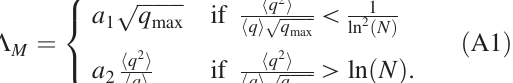
FIG. 7. Minimum sizes N for the validity of Eq. (1) in min uncorrelated power-law networks as a function of the degree exponent γ . Values in the vicinity of γ ¼ 5 = 2 not plotted are all larger than 10 30